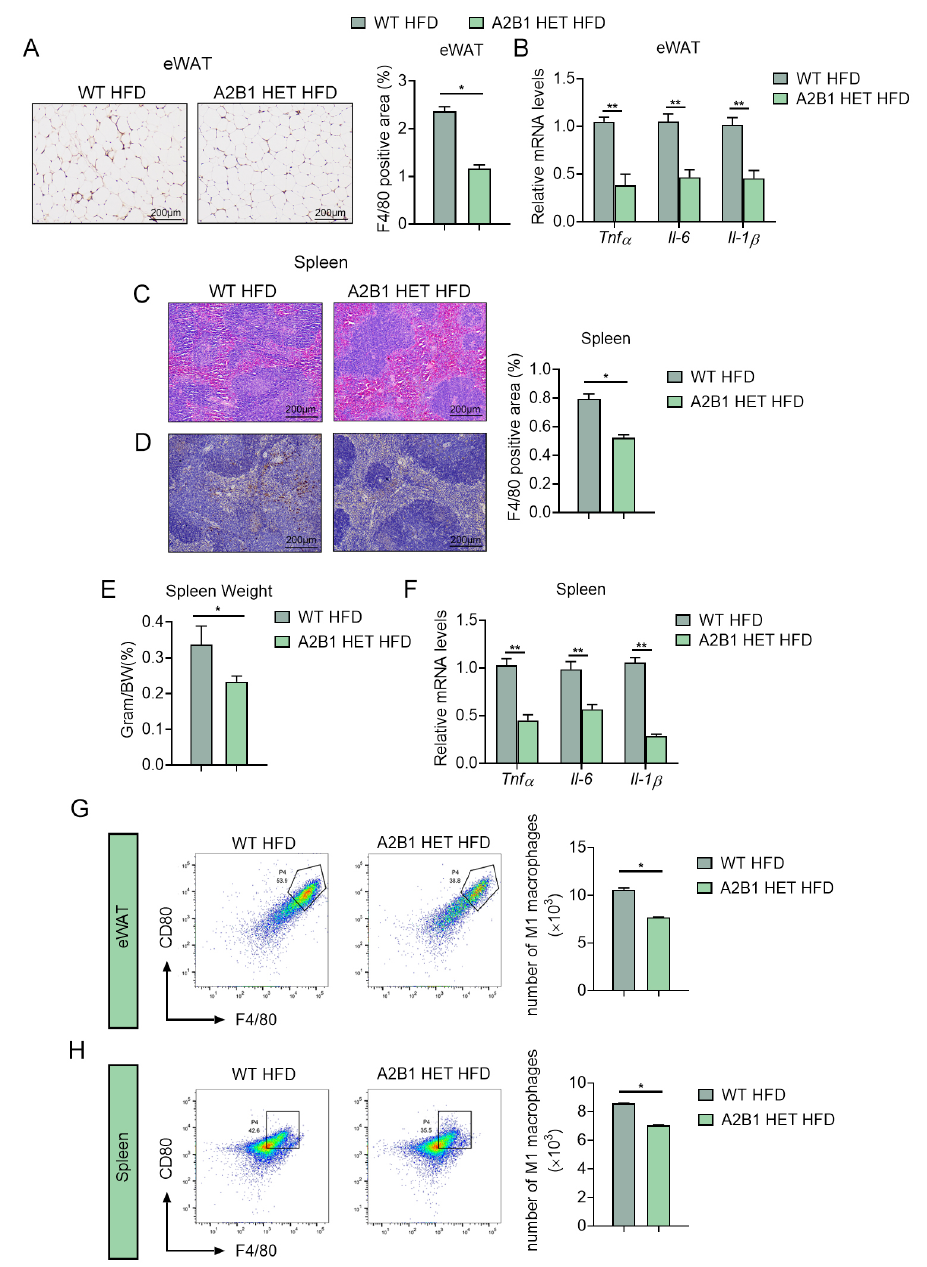
Figure 5. hnRNPA2B1 deficiency reduces M1 macrophages and inhibits inflammatory responses after HFD feeding. ( A ) Immunohistochemistry analysis of F4/80 levels in epididymal white adipose tissues. ( B ) Relative Tnf α , Il-6 and Il-1 β mRNA expression levels in epididymal white adipose tissues of HFD-fed WT and A2B1 HET mice. ( C – F ) H&E staining of spleen ( C ), Immunohistochemistry analysis of F4/80 levels in spleen ( D ), Spleen-to-body-weight ratio ( E ) and Relative proinflammatory genes mRNA levels ( F ) in spleen of HFD-fed WT and A2B1 HET mice. ( G , H ) Representative images and numbers of CD45+F4/80+CD80+ macrophages in epididymal white adipose tissues ( G ) and spleen ( H ) of HFD-fed WT and A2B1 HET mice analyzed by FACS. Results are shown as mean ± SEM; * p < 0.05, ** p < 0.01.